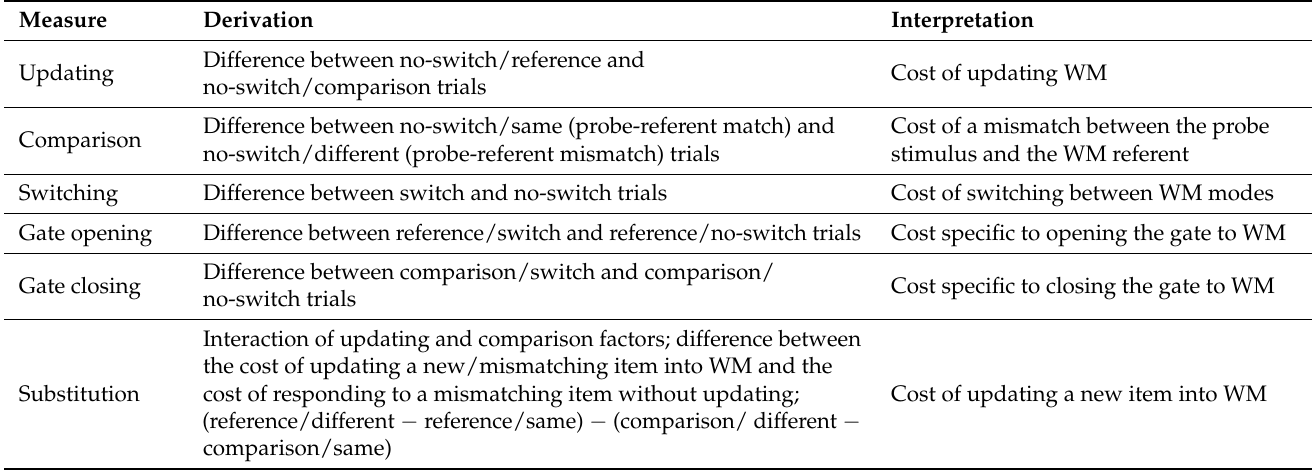
Table 1. Cost measures derived from the reference-back